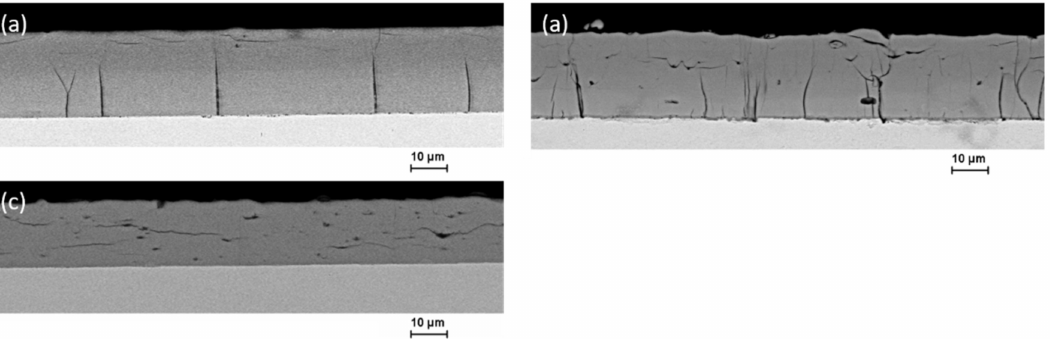
Figure 9. SEM micrographs of cross-sections of electrodeposited Fe-Cr-Ni coatings under DC 18 A/dm 2 conditions for three depositions ( a ) first deposition (2 h of electrolyte use) with mi- crocracks; ( b ) second deposition (4 h of electrolyte use) with microcracks; and ( c ) third deposition (6 h of electrolyte use) with horizontal microcracks.